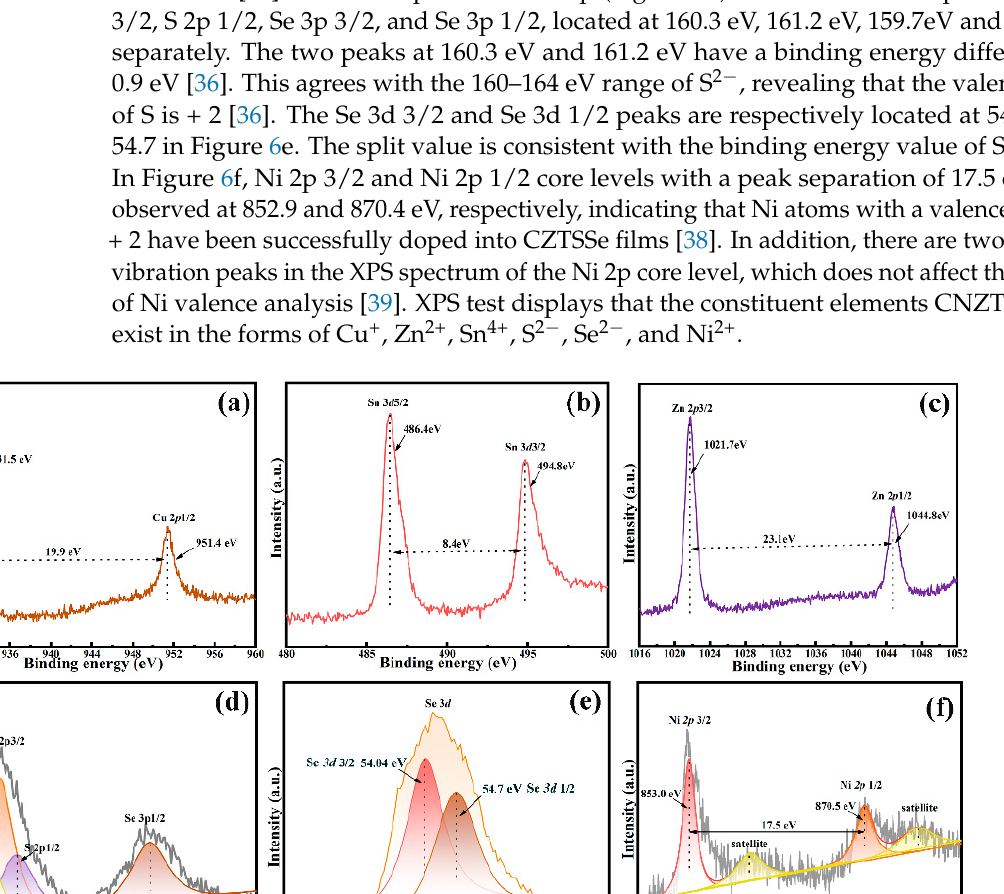
Table 1. EDS results of the CNZTSSe films at selenidation times of 10 min, 15 min, and 20 min.